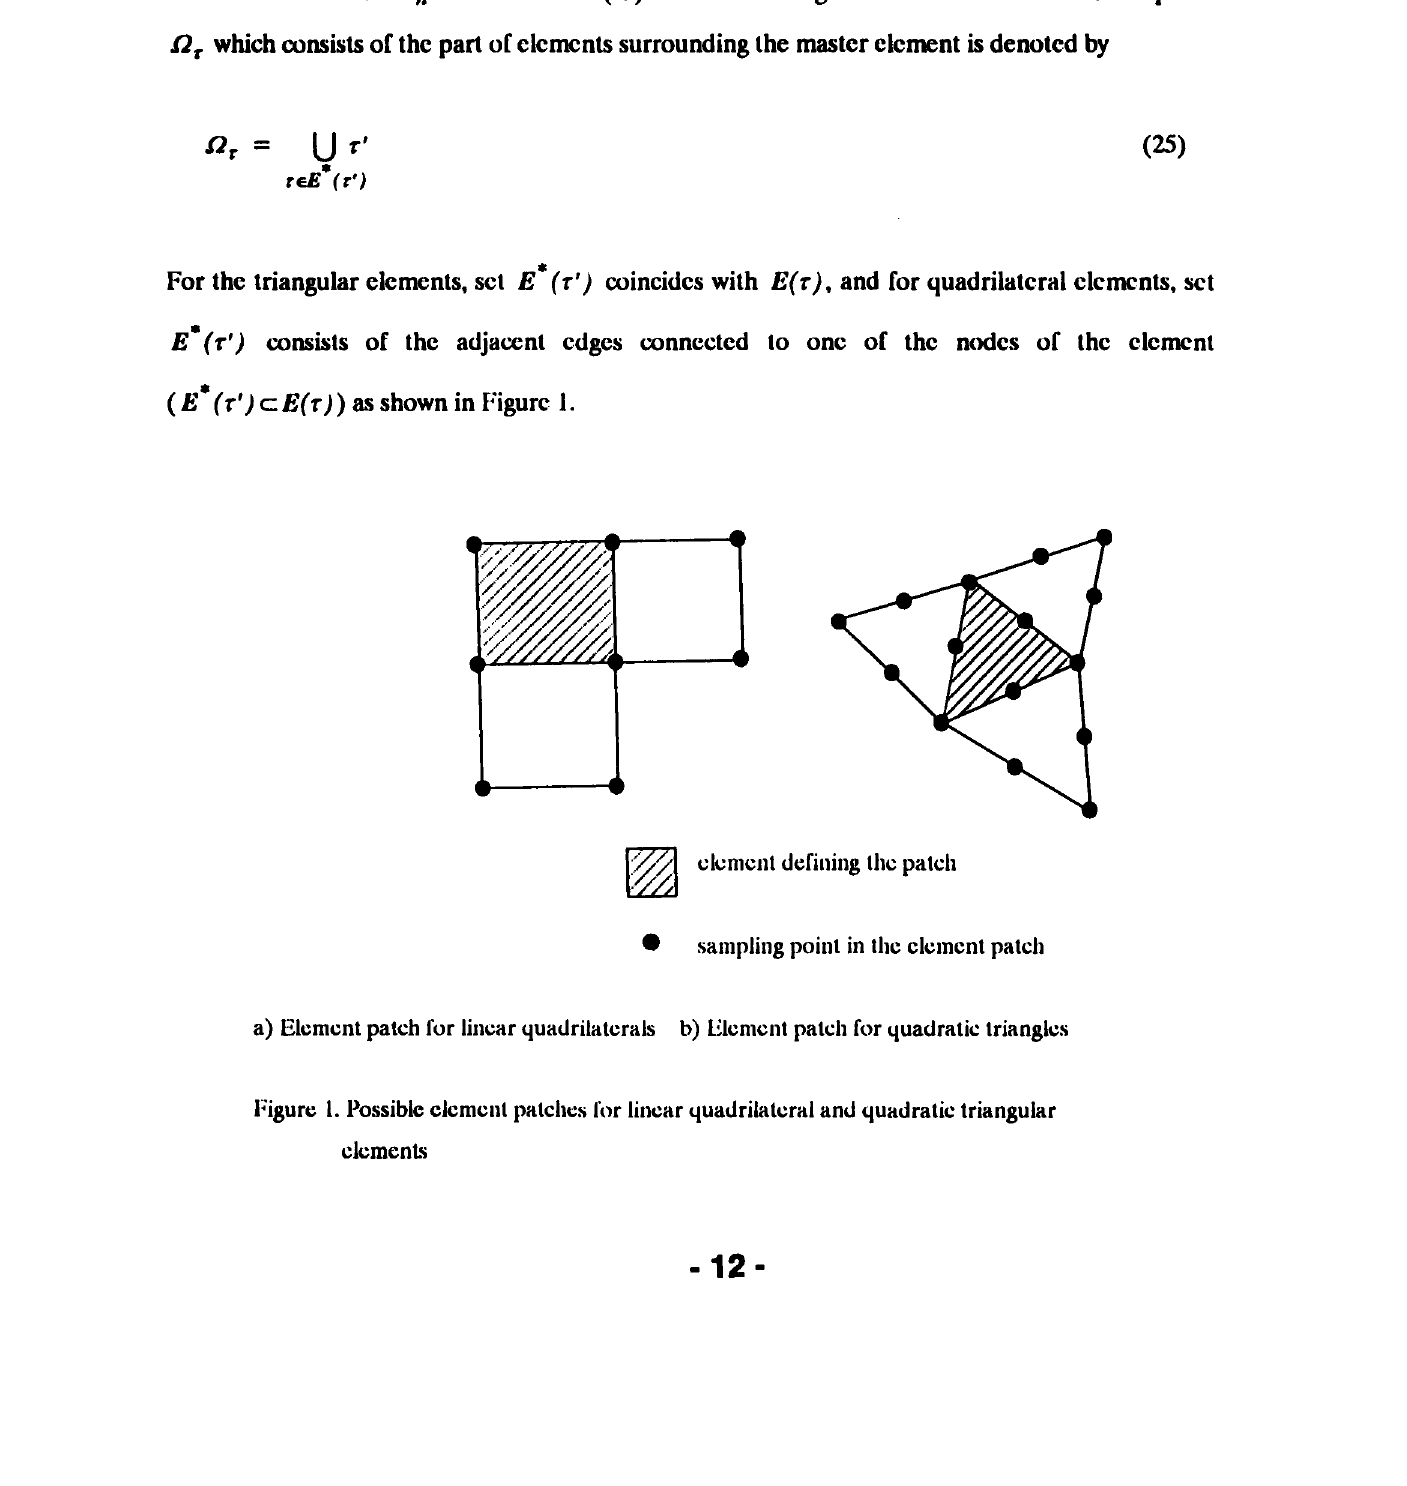
Figure I. Possible clement patches for linear quadrilateral and quadratic triangular